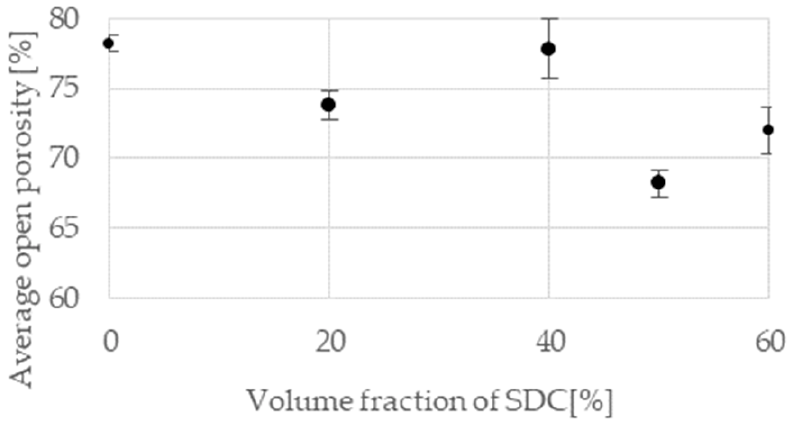
Figure 6. Influence of SDC volume fraction on the average cathode open porosity.